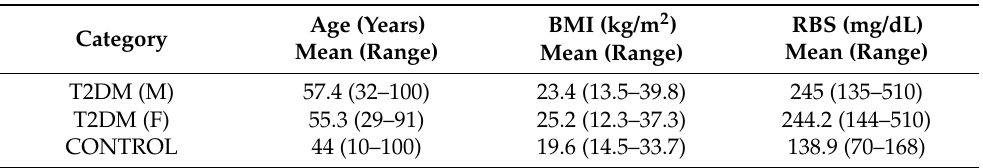
Table 1. Upper and lower ranges and mean values of different variables in Type 2 Diabetes Mellitus (T2DM) patients and healthy controls.